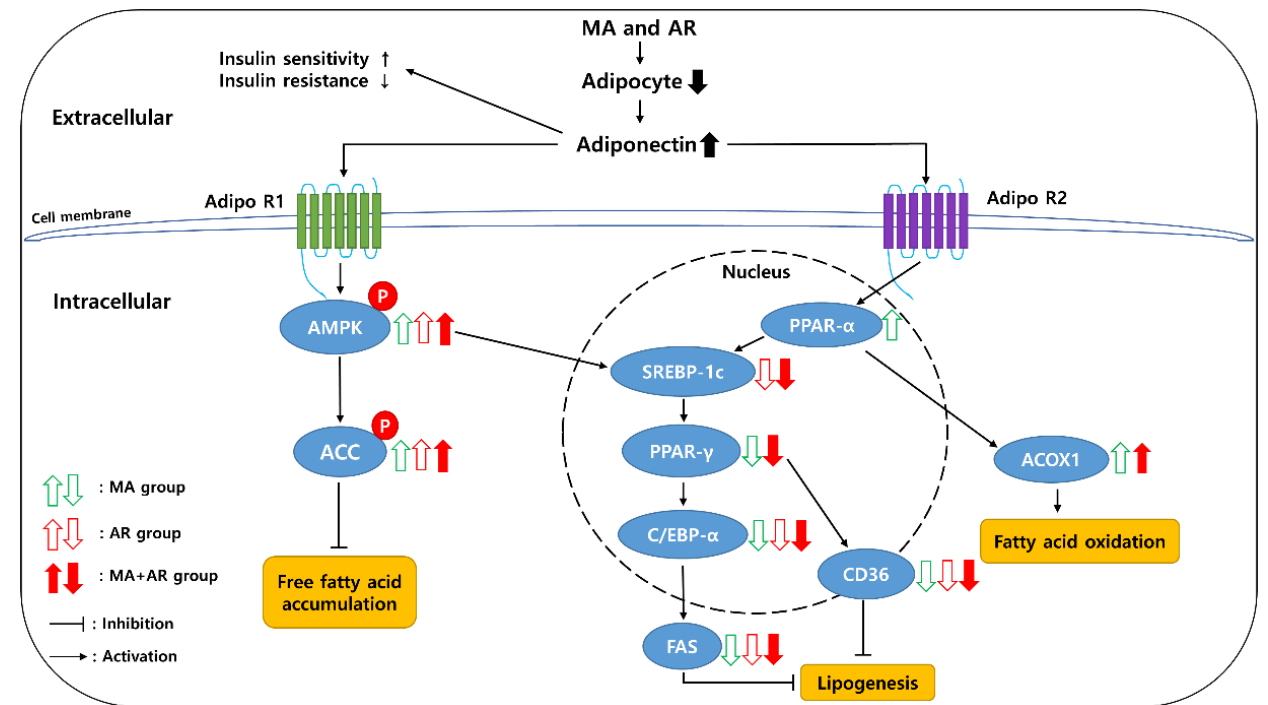
Figure 7. Schematic mechanistic diagram showing anti-obesity effect of MA and AR.